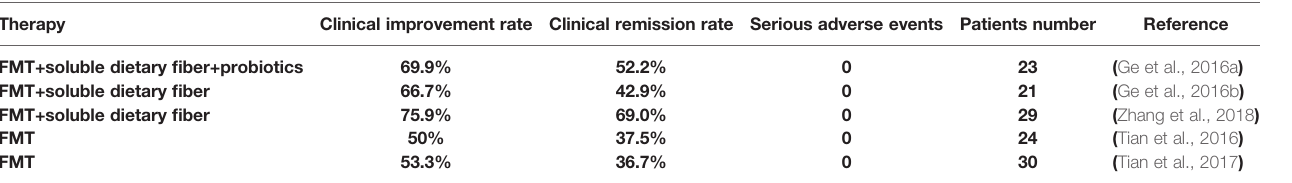
TABLE 1-1 | The clinical ef fi cacy of FMT reported in the literatures. Therapy